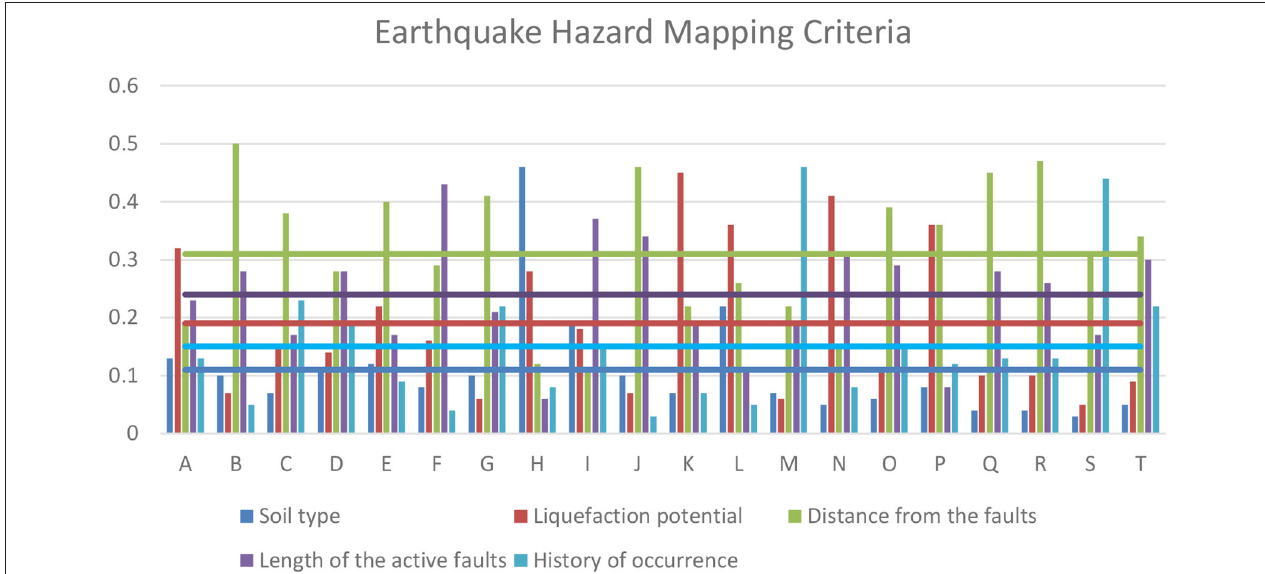
FIGURE 5 | Weights of the criteria for earthquake hazard mapping using AHP showing the mean values in horizontal lines.